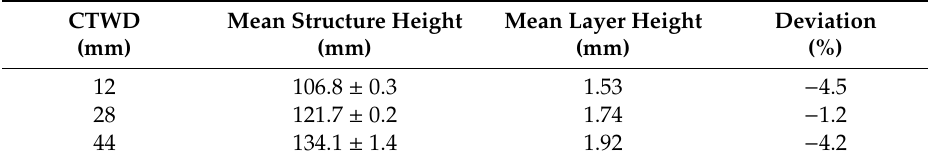
Table 2. Structure height of large WAAM structures and comparison to previous trials (compare Figure